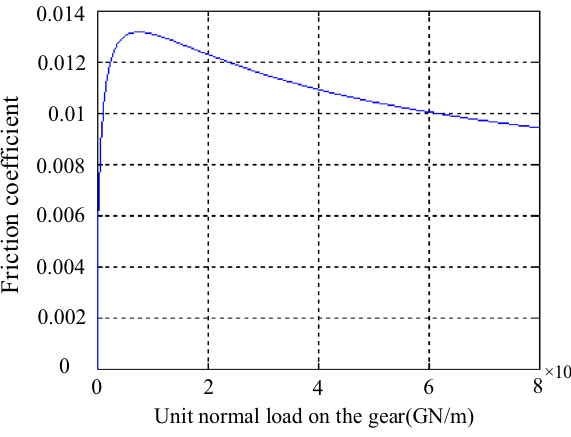
Unit normal load on the gear(GN/m)